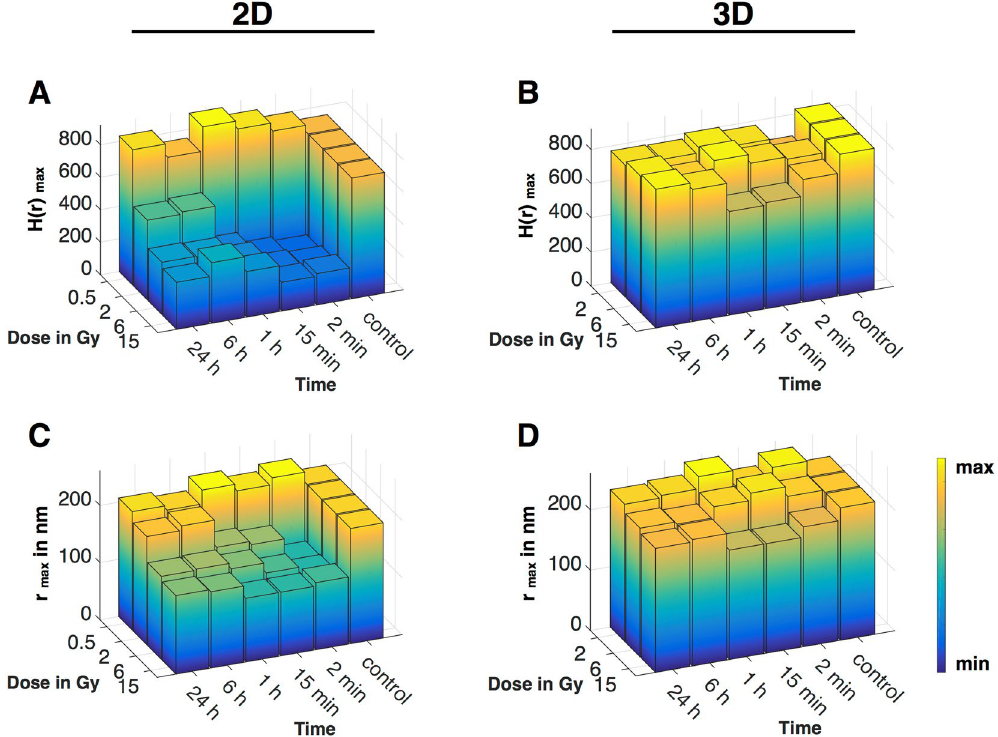
Figure 4. Effects of IR on the cluster density (H (r) max) and the cluster radius (r max in nm) of β 1 integrins of 2D and 3D cultured MEF cells. Bar plots of medians of H (r) max and r max obtained from H-Plots of Ripley’s K function analysed datasets (S6), visualised as a combination of bar plot and heat map (low value in blue, high value in yellow). For 2D cells N = 2 and n = 20, for 3D cells N = 2 and n = 10. Controls were pooled, therefore for 2D cells N = 8, n = 80 and for 3D cells N = 6, n = 30. 2D cells were irradiated with 0.5, 2, 6 and 15 Gy, 3D cells were irradiated with 2, 6 and 15 Gy. Cells were fixed and stained as controls, 2 min, 15 min, 1 h, 6 h and 24 h after IR. ( A ) Plot of H max of 2D cultured cells. ( B ) Plot of r max of 2D cultured cells. ( C ) Plot of H max of 3D cultured cells. ( D ) Plot of r max of 3D cultured cells. For a better visualisation significances are displayed in S6.